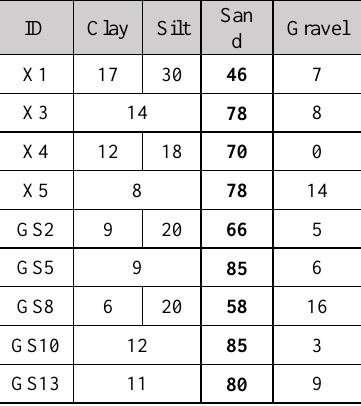
Table 2. The sediment samples used in this study and their composite percentage (%). The bold values highlighted the percentage % of sand are the highest amongst other samples.